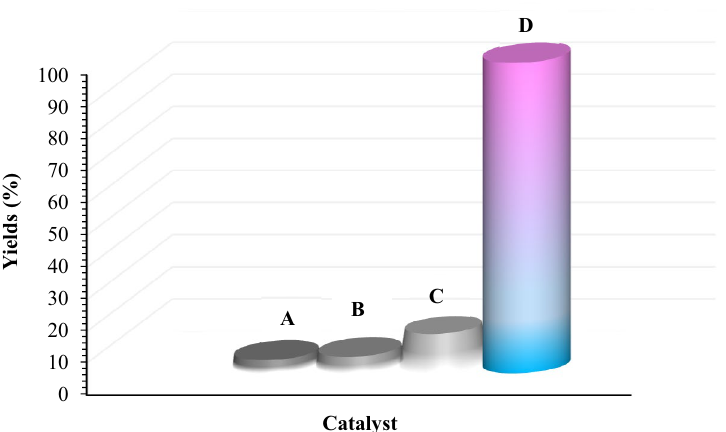
Figure 9. Comparison of the efficiency of ( A ) Fe 3 O 4 , ( B ) Pectin, ( C ) Fe 3 O 4 @Pectin, and ( D ) Fe 3 O 4 @Pectin@ (CH 2 ) 3 -Acetamide-Cu(II) in model reaction. Reaction conditions: Benzyl chloride (1.0 mmol), Sodium azide (1.2 mmol), phenylacetylene (1.0 mmol), catalyst (0.5 mol %), H 2 O (2 ml) as a solvent at 65° C for 120 min.